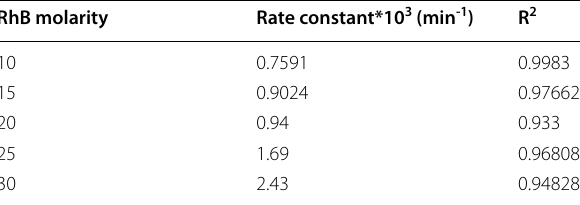
Table 2 Rate constant and R 2 values obtained from the linear fit of the logarithmic plot of (C /C) versus time for different RhB dye 0 concentrations